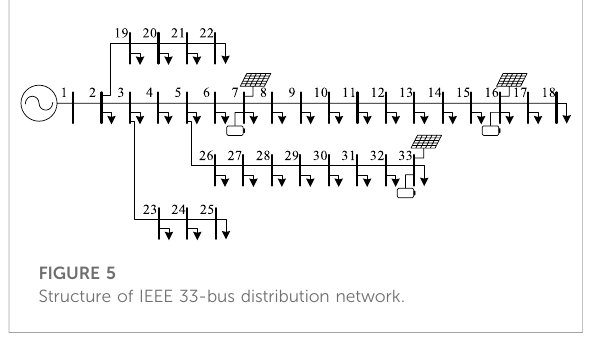
FIGURE 5 Structure of IEEE 33-bus distribution network.